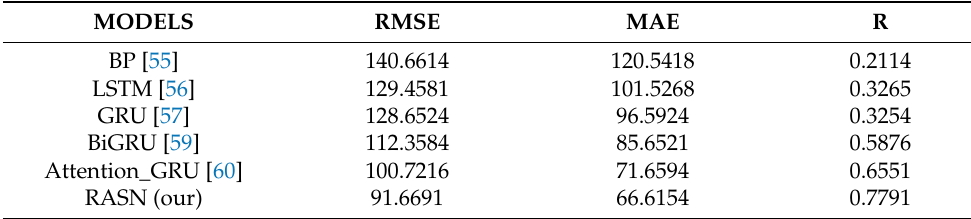
Table 5. Comparison of model prediction performance based on light intensity data.